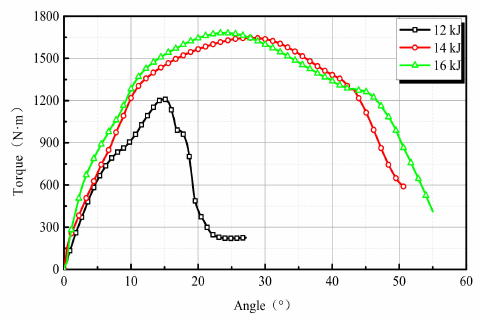
Figure 5. Torque force-angle curve of electromagnetic crimped joints formed under different dis- charge